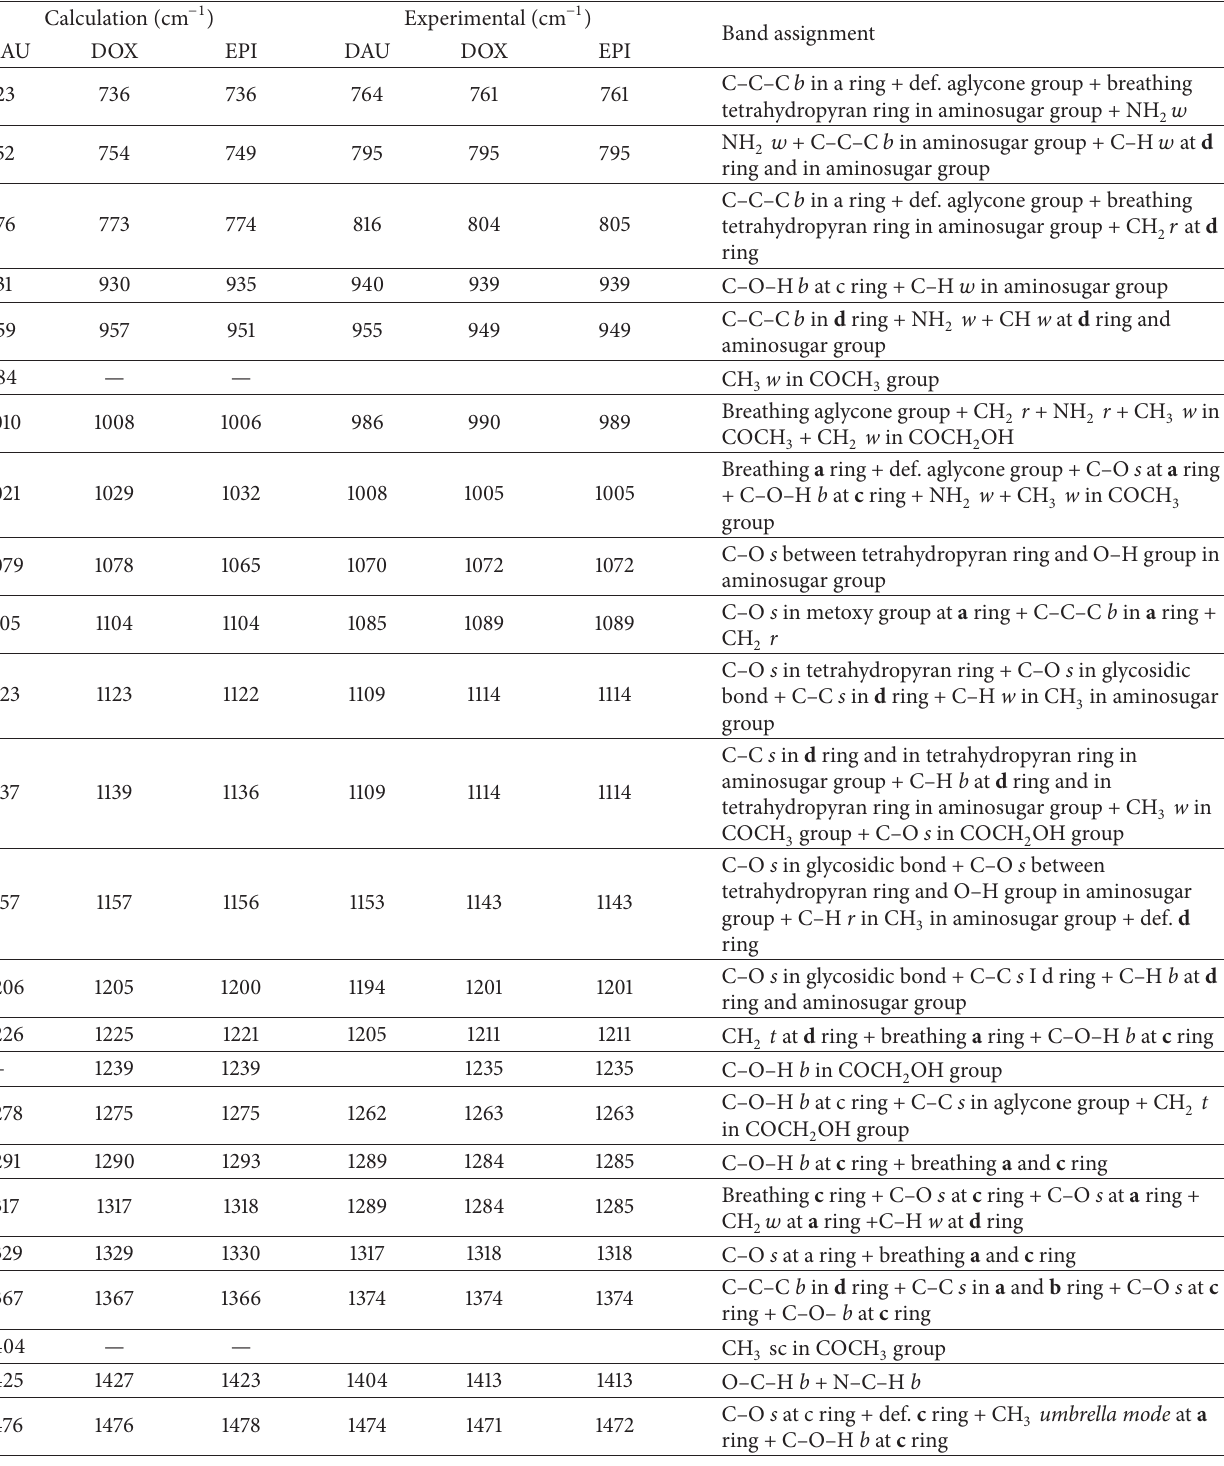
Table 1: Main characteristic vibrational modes of daunorubicin (DAU), doxorubicin (DOX), and epidoxorubicin (EPI) observed in experimental and calculated